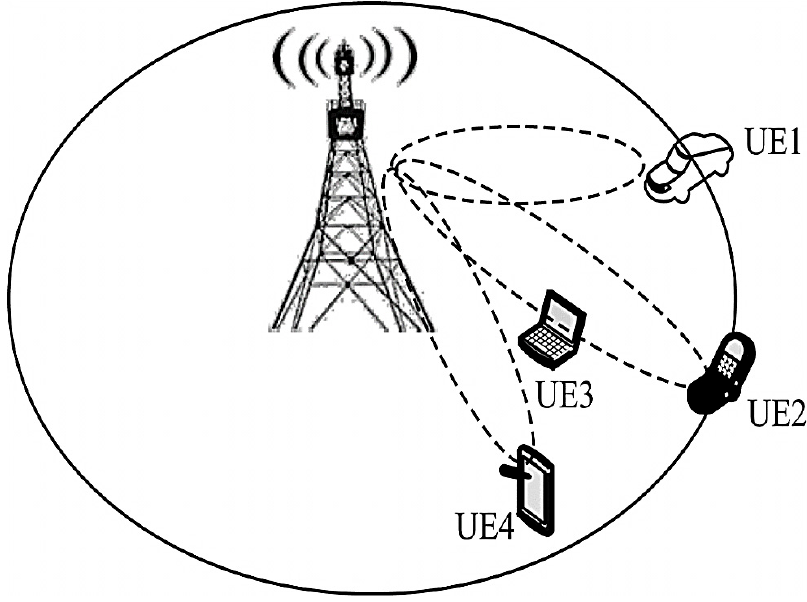
Figure 1. Conventional antenna beamforming.